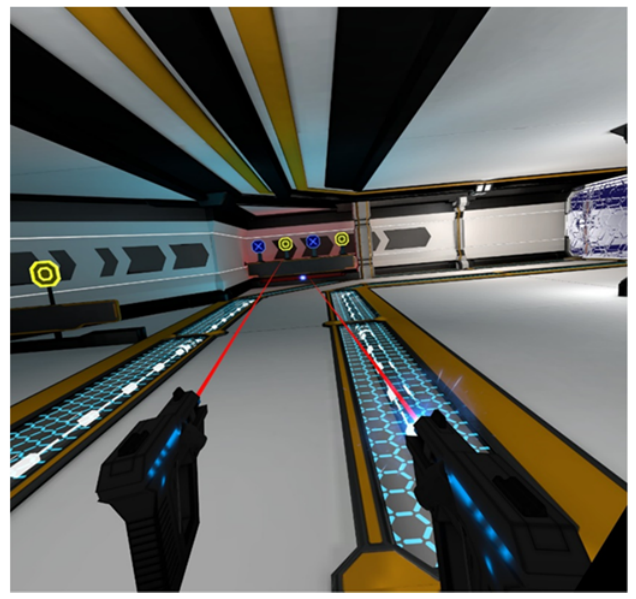
Figure 3. Gameplay of Travar Training OPS game: print screen. Table 1. Attractiveness of active video games (AVGs) in immersive virtual reality (IVR) using OMNI treadmills and their competitiveness compared to conventional computer games and other forms of physical activity (PA) according to the obese